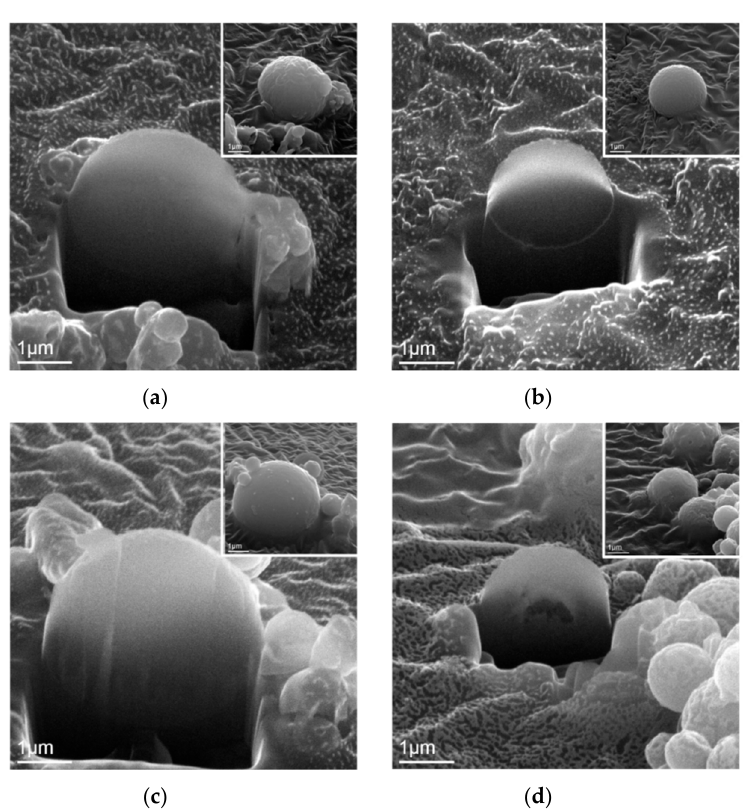
Figure 4. SEM images of focused ion beam-prepared cross-sectional solid particles of ( a ) pure BG powder, ( b ) YAc, and ( c ) YN derived Y-doped BG powders. ( d ) Cross sectional hollow particle of YN-derived Y-doped powder.